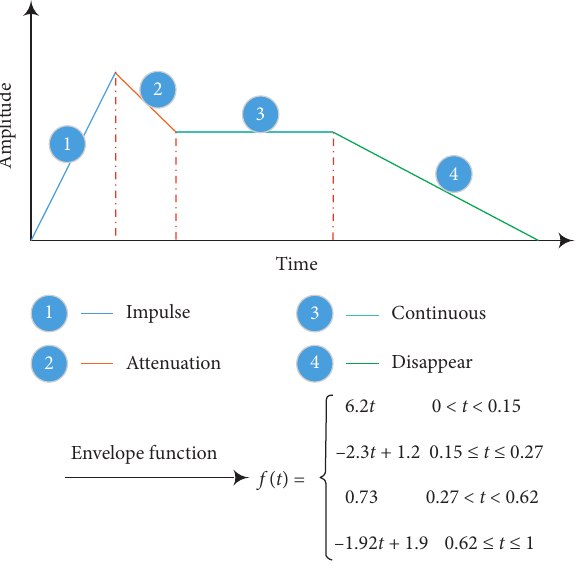
Figure 3: ADSR envelope